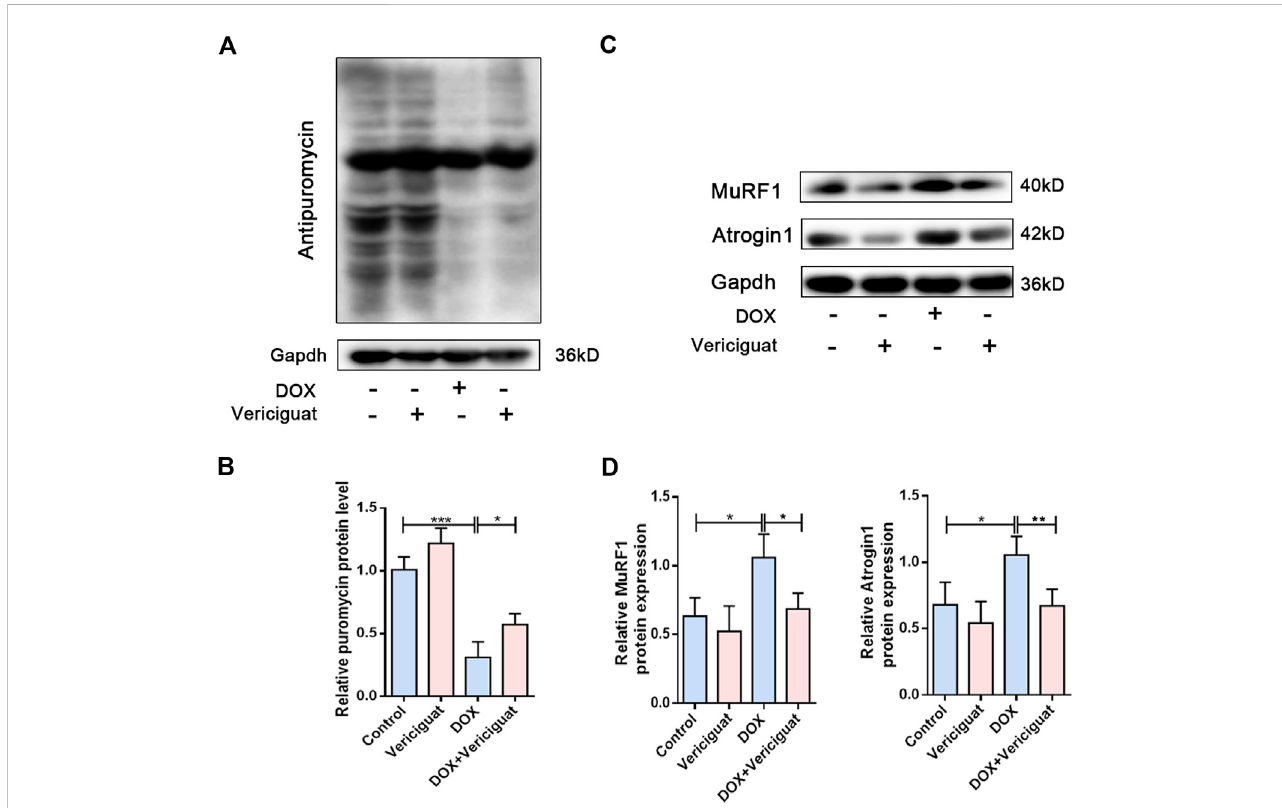
FIGURE 4 Vericiguat increased protein synthesis. (A) Expression of puromycin detected through western blot. (B) Relative protein expression levels of puromycin. (C) ExpressionofMuRF1 andAtrogin1detectedthroughwesternblot. (D) RelativeproteinexpressionlevelsofMuRF1andAtrogin1.n=5; *p < 0.05, **p < 0.01, ***p <